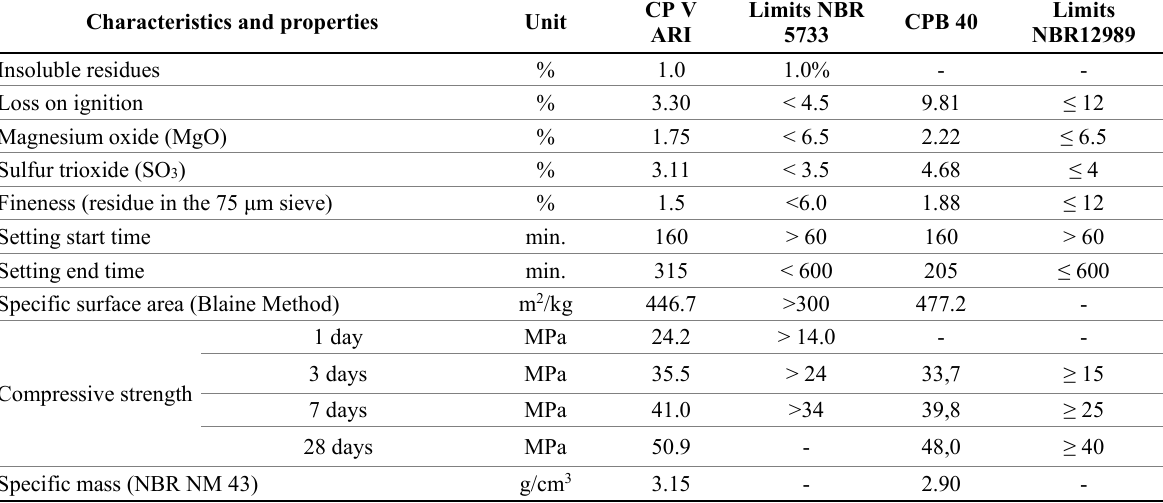
Table 1. Physical and chemical characteristics of the cements used (Source: the authors, 2020). Characteristics and properties